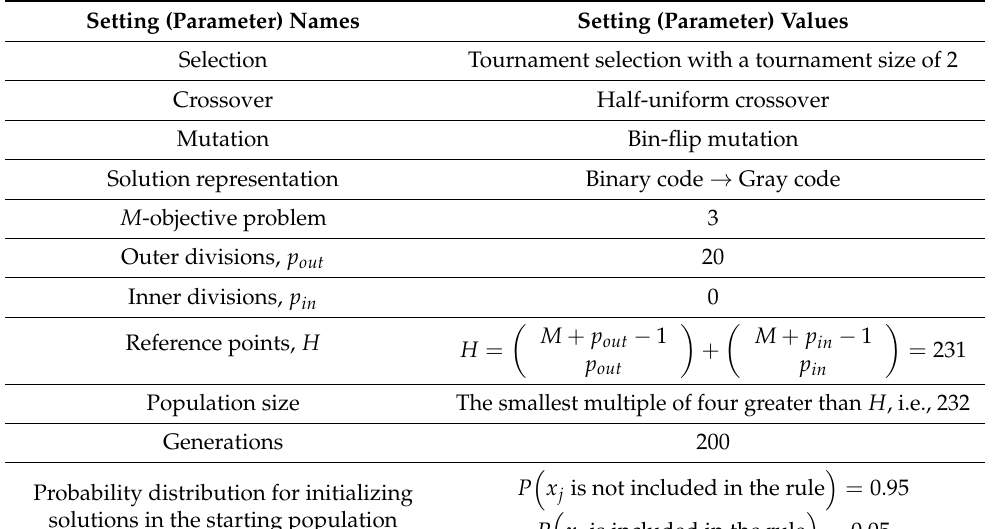
Table 1. The Non-dominated Sorting Genetic Algorithm III (NSGA III) settings used in the experiment.